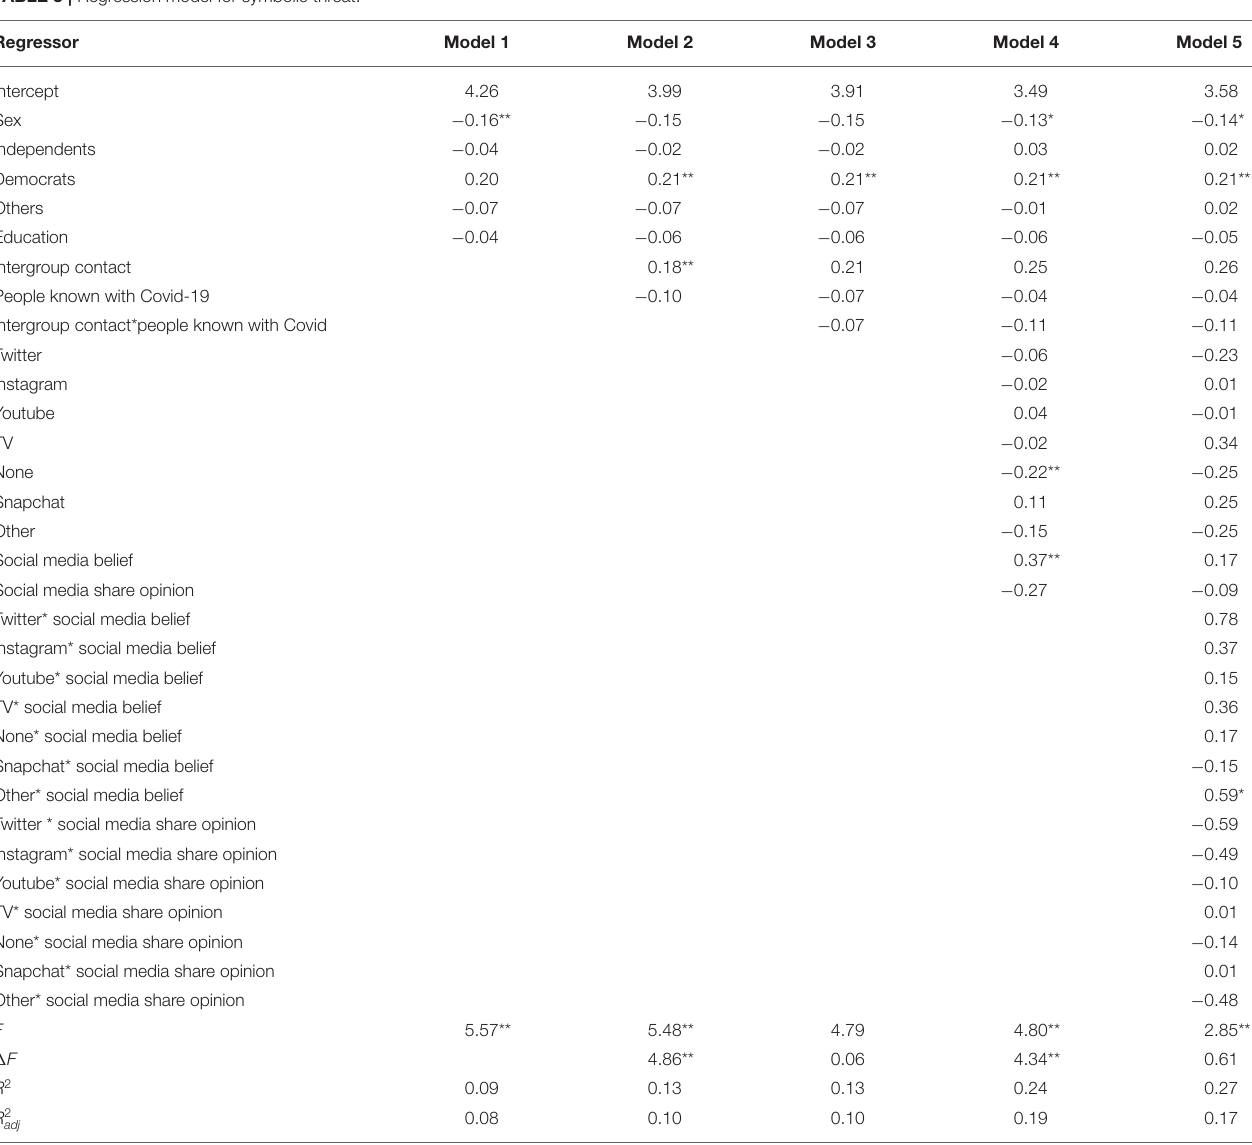
TABLE 3 | Regression model for symbolic